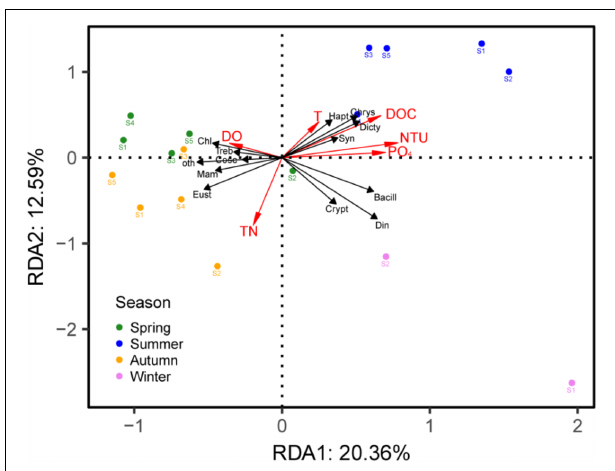
FIGURE 6 | RDA triplots of samples, environmental parameters and the main taxa of PPEs in Lake Fuxian. Bacill, Bacillariophyceae; Cosc, Coscinodiscophyceae; Chl, Chlorophyceae; Mam, Mamiellophyceae; Treb, Trebouxiophyceae; Chrys, Chrysophyceae; Crypt, Cryptophyceae; Dicty, Dictyochophyceae; Din, Dinophyceae; Eust, Eustigmatophyceae; Hapt, Haptophyta; Syn, Synurophyceae; oth, other